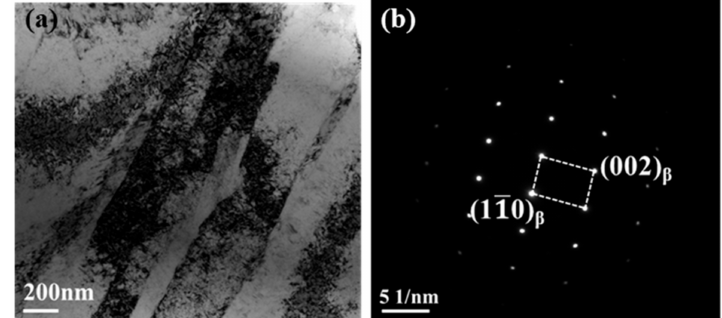
Figure 3. Microstructure of EP0.58 after tensile tests at 293 K: ( a ) Bright field image, ( b ) (110) β zone axis selected area electron di ff raction (SEAD)